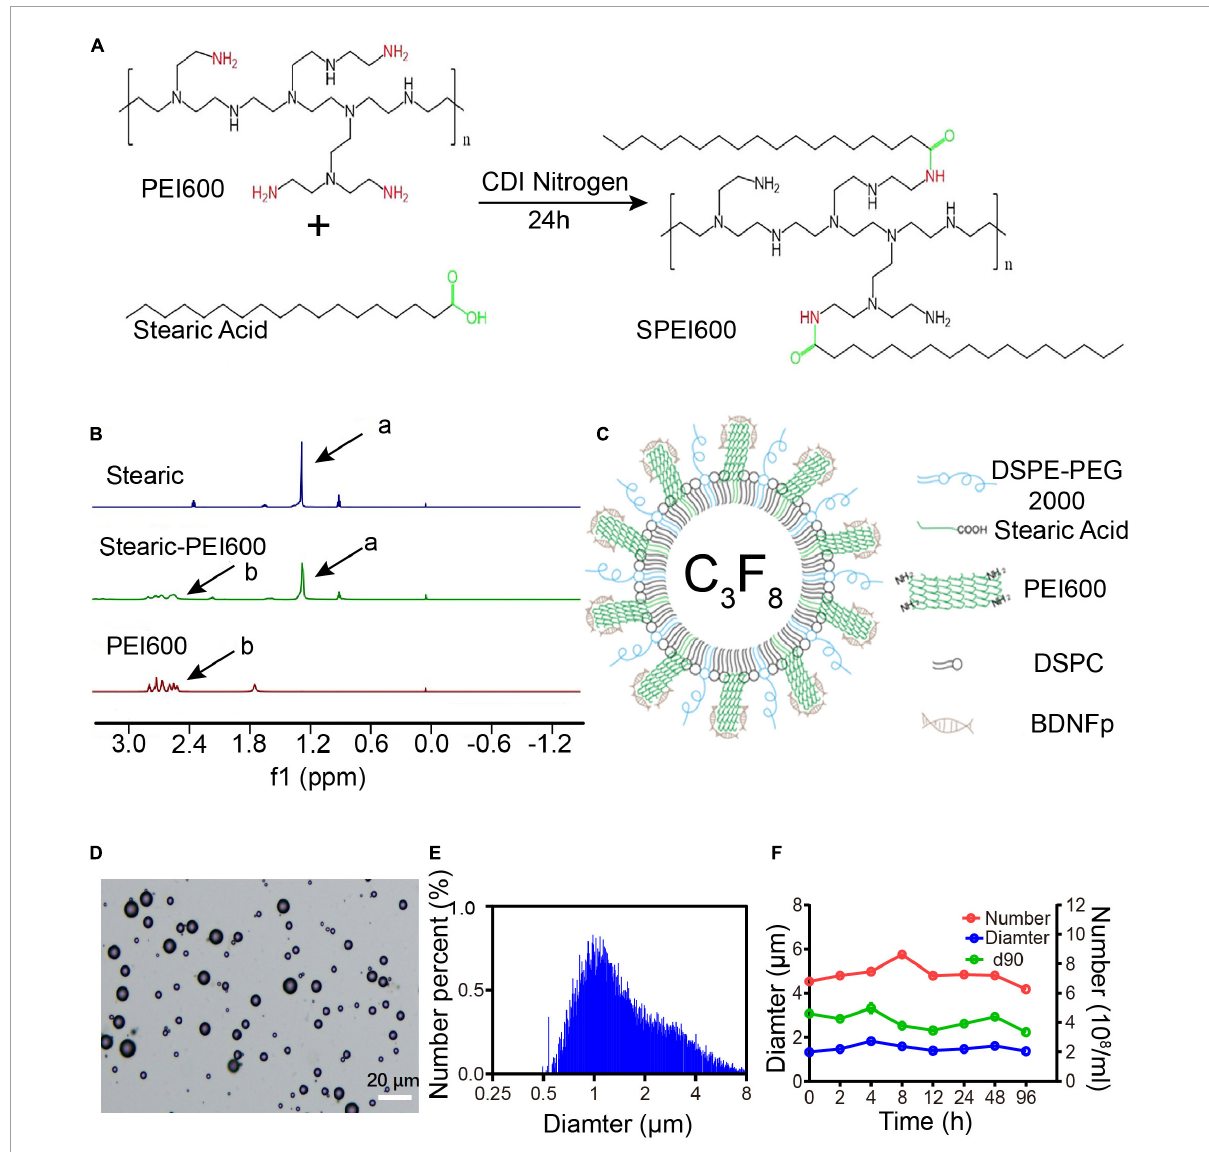
FIGURE1 Preparation and characteristics of cationic microbubbles (CMBs). (A) SPEI600 synthesis diagram. (B) Hydrogen spectra of stearic acid, PEI600, and SPEI600 in CDCl3 (a: - CH2-, b: PEI). (C) CMB structure mode diagram. (D) Morphological distribution of CMBs. (E) CMB particle size distribution. (F) Particle size, concentration, and d90 of CMBs at different